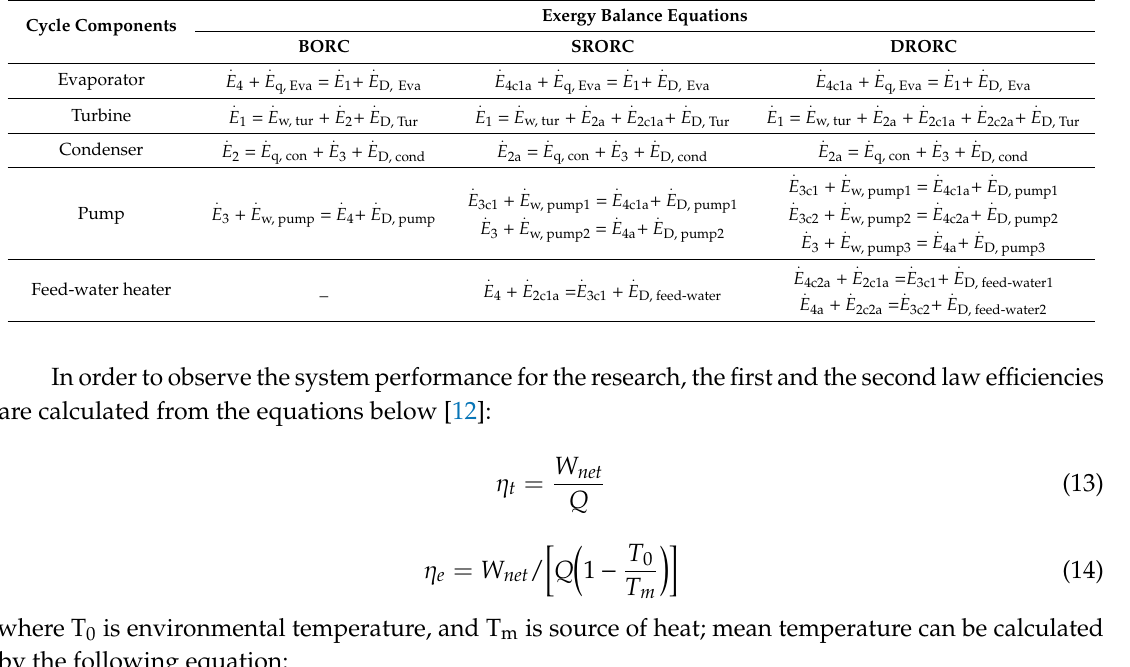
Table 1. Balance of exergy for any components of the systems. BORC: basic organic Rankine cycle, SRORC: single-regeneration ORC and DRORC: double-regeneration